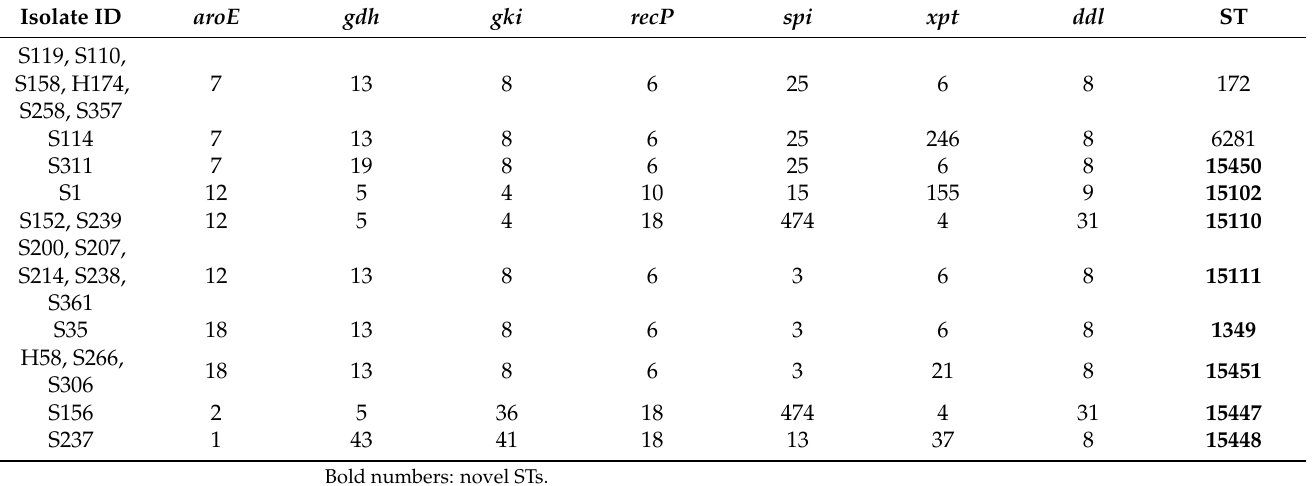
Table 2. MLST of serotype 23B pneumococcal isolates.